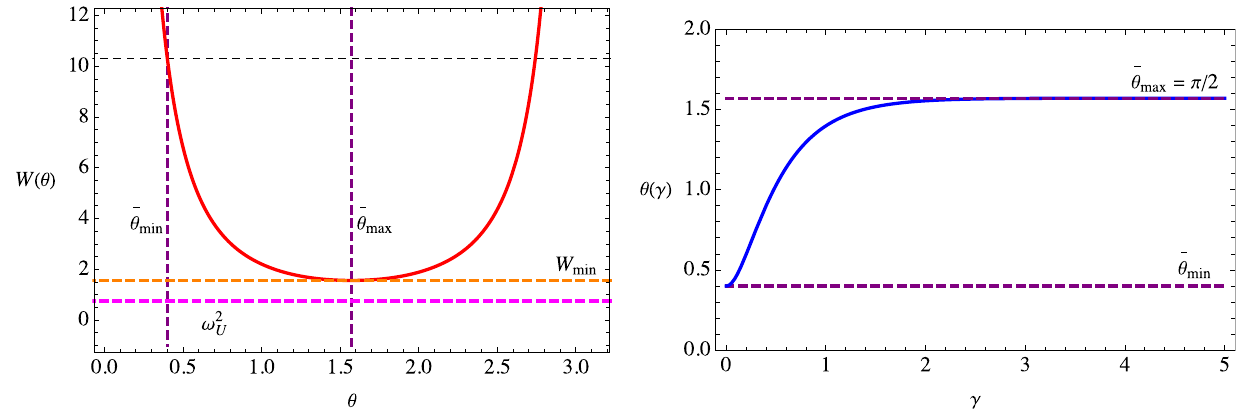
Fig. 9 The angular effective potential and the temporal evolution of the coordinate θ , for the case of ˜ η = 0 (which here corresponds to Q = f θ = √ 9 M 2 ). To plot θ(γ) , we have considered ω 0 = 10 . 30